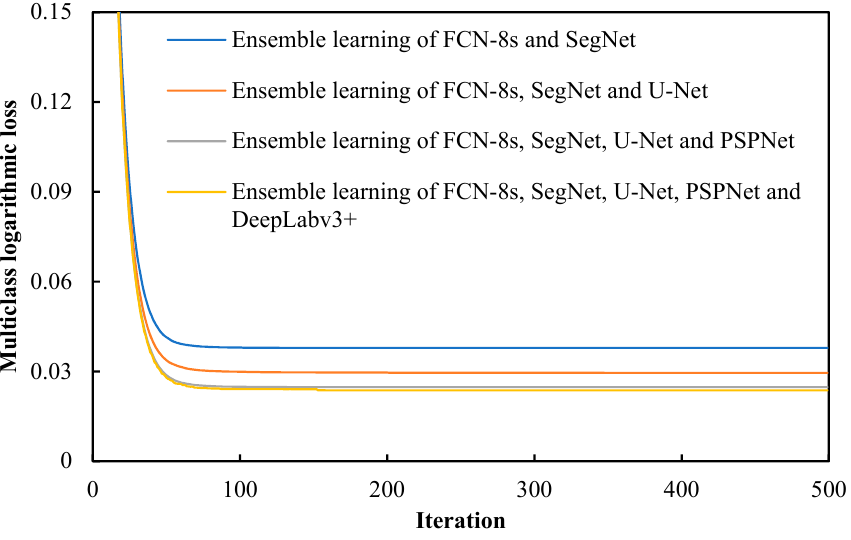
Figure 7. Multiclass logarithmic losses over iterations of four ensemble learning models.